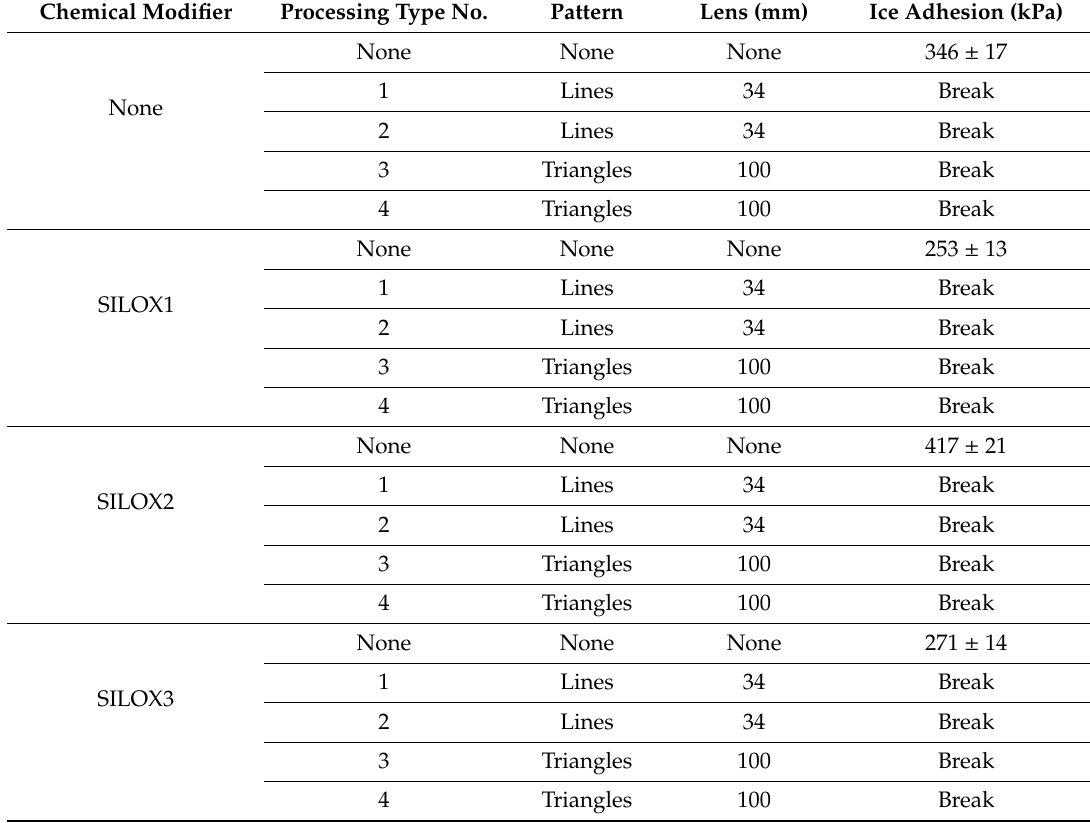
Table 5. Ice adhesion test results.